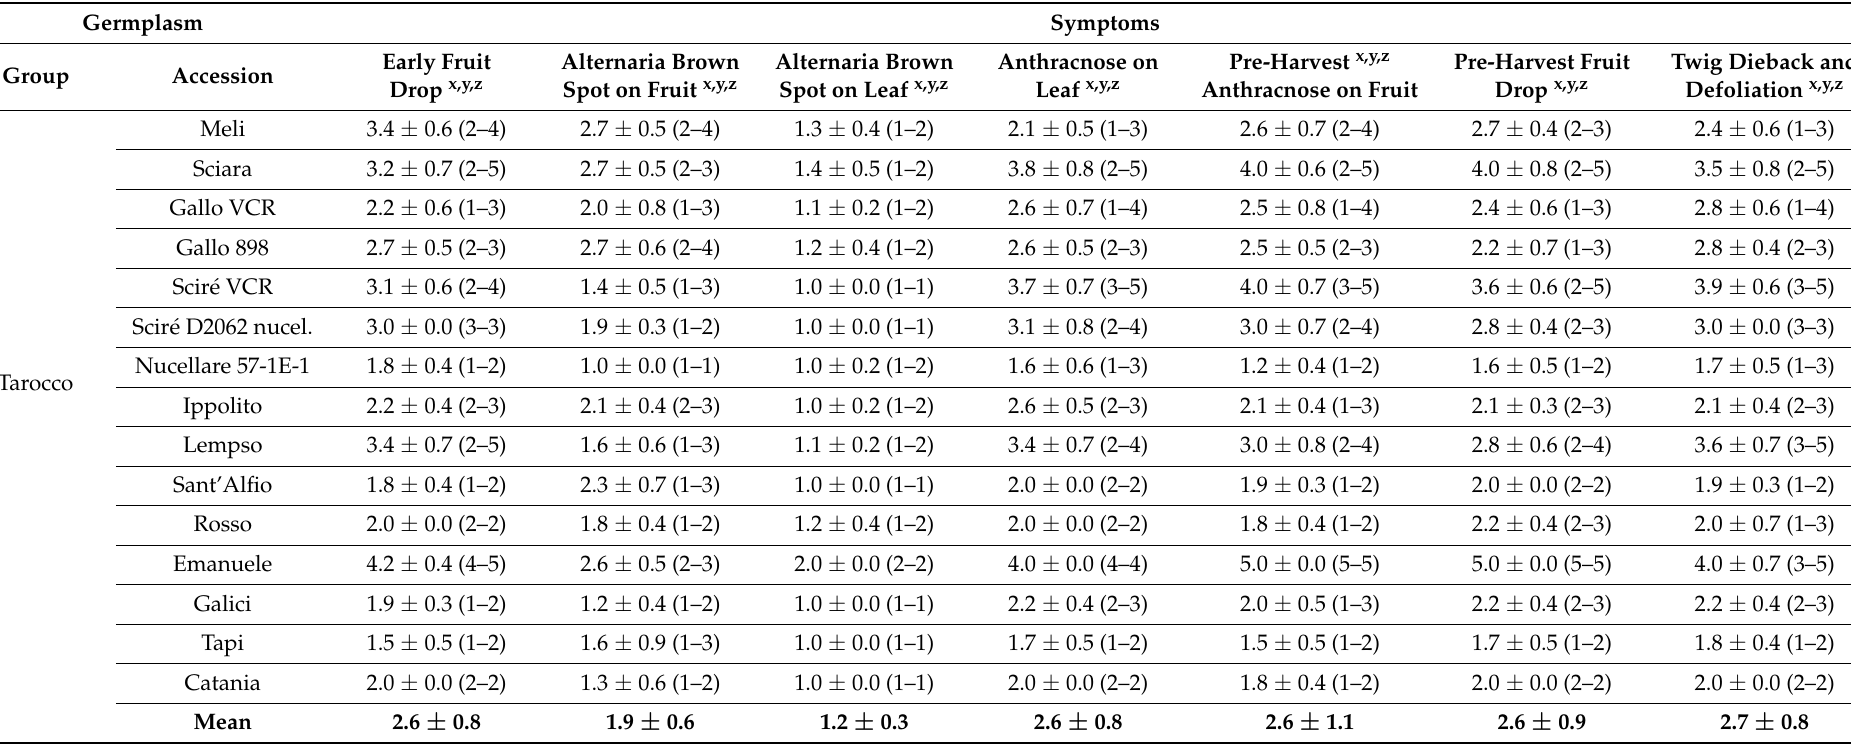
x Disease data for each cultivar/clone are the means of three replicates, each relative to three monitoring periods (2010–2013, 2014–2017, 2018–2020), obtained from 20 representative Citrus production areas (at least one area monitored over two periods) in eastern Sicily. y Mean disease scores were calculated according to an empirical 0-to-5 disease incidence scale taking into account the percentage of citrus organs in the canopy where 0 = healthy canopy; 1 = from 1 to 5% of infected fruit/leaves/twigs in the canopy; 2 = from 6 to 15% of infected fruit/leaves/twigs in the canopy; 3 = from 16 to 30% of infected fruit/leaves/twigs in the canopy; 4 = from 31 to 60% of infected fruit/leaves/twigs in the canopy, 5 = from 61 up to 100% of infected fruit/leaves/twigs in the canopy. z Data are followed by standard deviation value and relative class range (min–max) monitored through surveyed time and